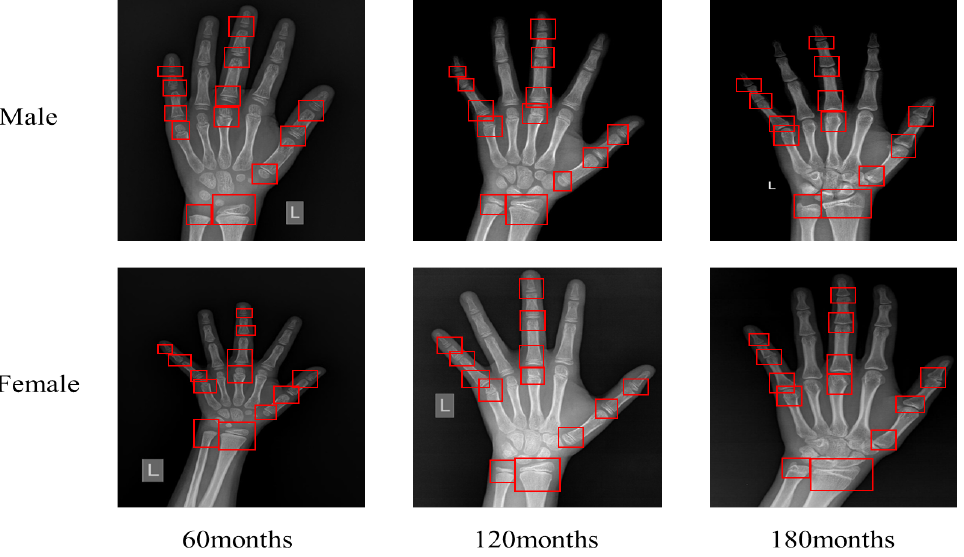
Figure 1. Left hand X-ray images of male and female children at different ages. The red boxes are the